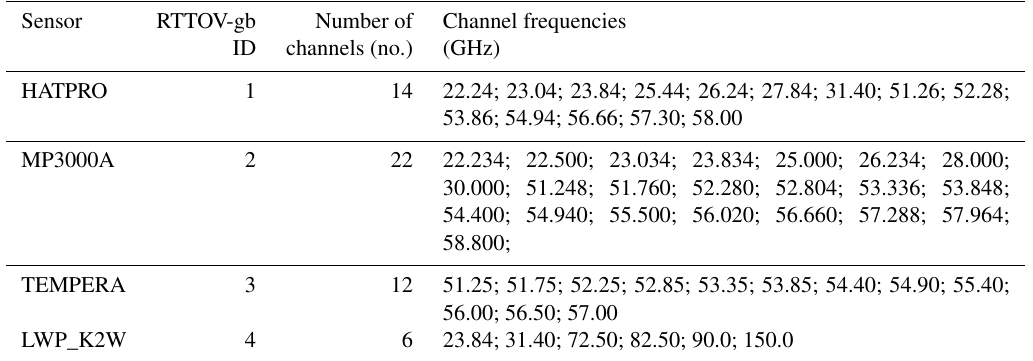
Table 2. Sensors supported by RTTOV-gb as for October 2018 (v1.0) with the corresponding number of channels and their central frequency.